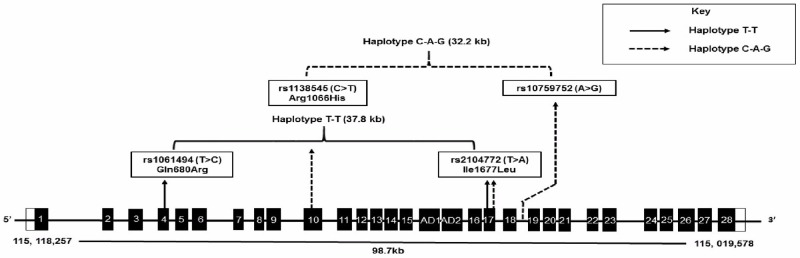
Risk-associated inferred haplotypes mapping to the TNC genomic interval.Diagram demonstrates two overlapping TNC inferred haplotypes associated with the risk of musculoskeletal soft tissue injuries including Achilles tendinopathy (rs1061494-rs2104772) and recurrent rotator cuff injuries (rs1138545-rs2104772-rs10759752) [6]. The genomic boundaries of TNC are provided according to the Human GRCh38.p10 genome release. Translation of mRNA starts in exon 2 demonstrated by double dash. Although the genomic coordinates are provided in the 5’ to 3’ direction, the TNC gene is orientated on the antisense strand. Black bars: Exons. Horizontal lines: Introns. Diagram not drawn to scale.